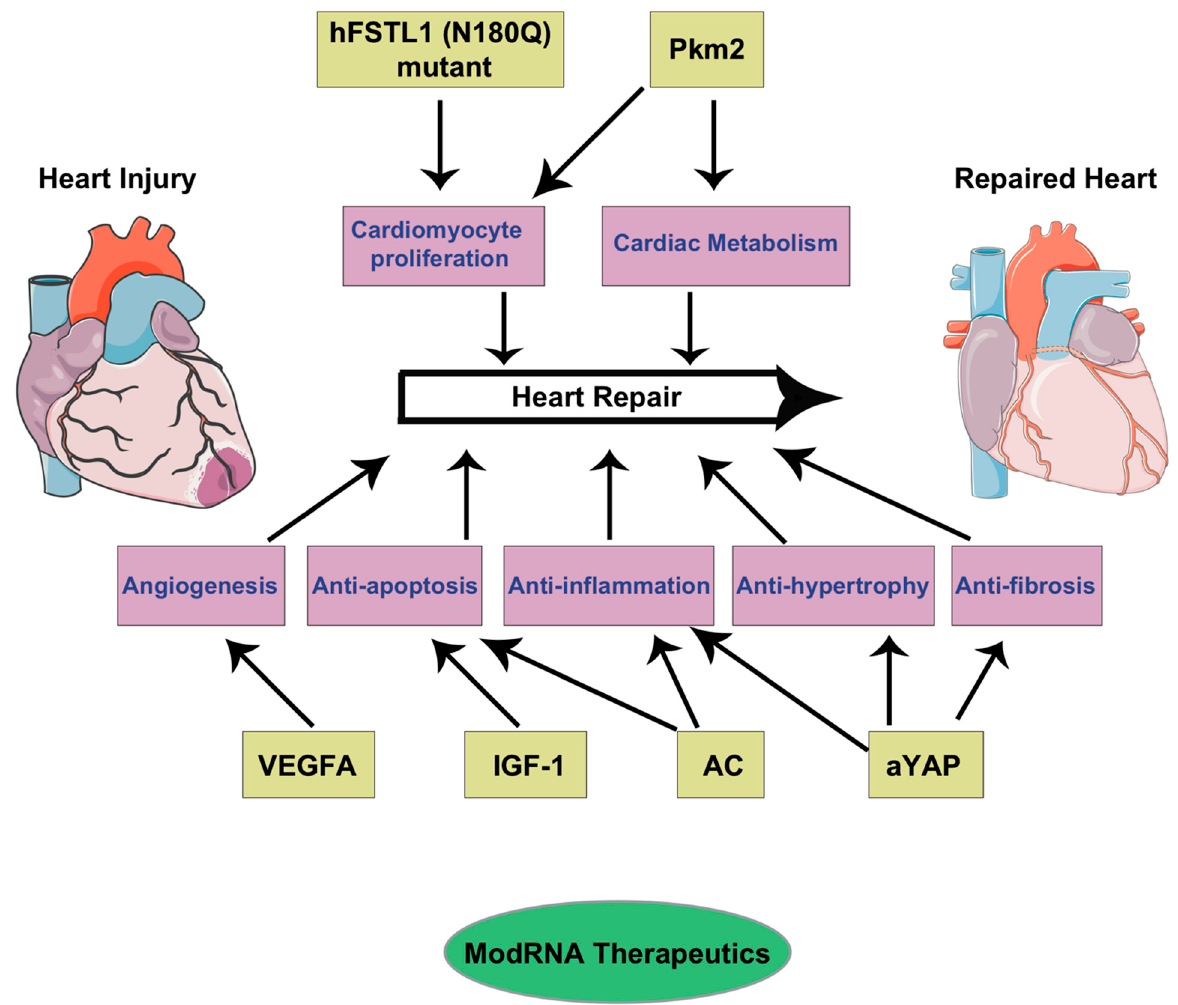
Figure 3. The delivery of modRNA based genes to heart to induce heart repair. Genes such as Pkm2, VEGFa, AC, aYAP, IGF1, and hFSTL1 (N180Q) mutated in the form of modRNA induce heart repair through cardiomyocyte proliferation, angiogenesis, cardiac protection, modulation of inflammation and cardiac metabolism, and inhibition of apoptosis and cardiac fibrosis.